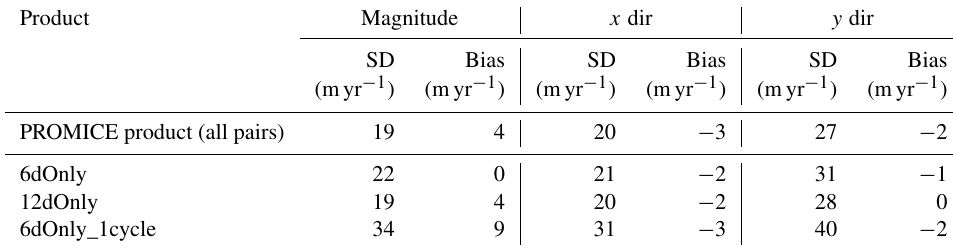
Table 5. Statistics of the validation of the satellite ice velocity products using PROMICE GPS data. Product